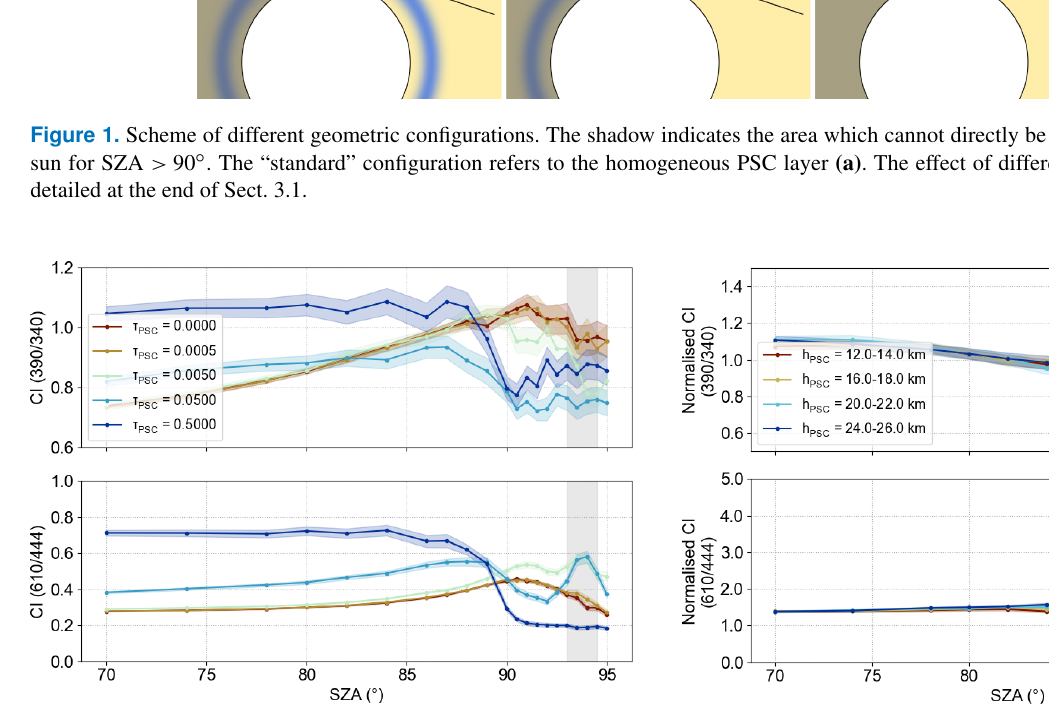
Figure 2. Simulation result for “standard” configuration (for details see text). Different colours correspond to different optical depths τ PSC (at 1µm) of the PSC layer ( h PSC = 20 to 22km). The shading of the 2 σ range indicates the noise of the results. The light grey shaded area depicts the SZA range (93.0 to 94.5 ◦ ) which is used in the analysis of the measured spectra.